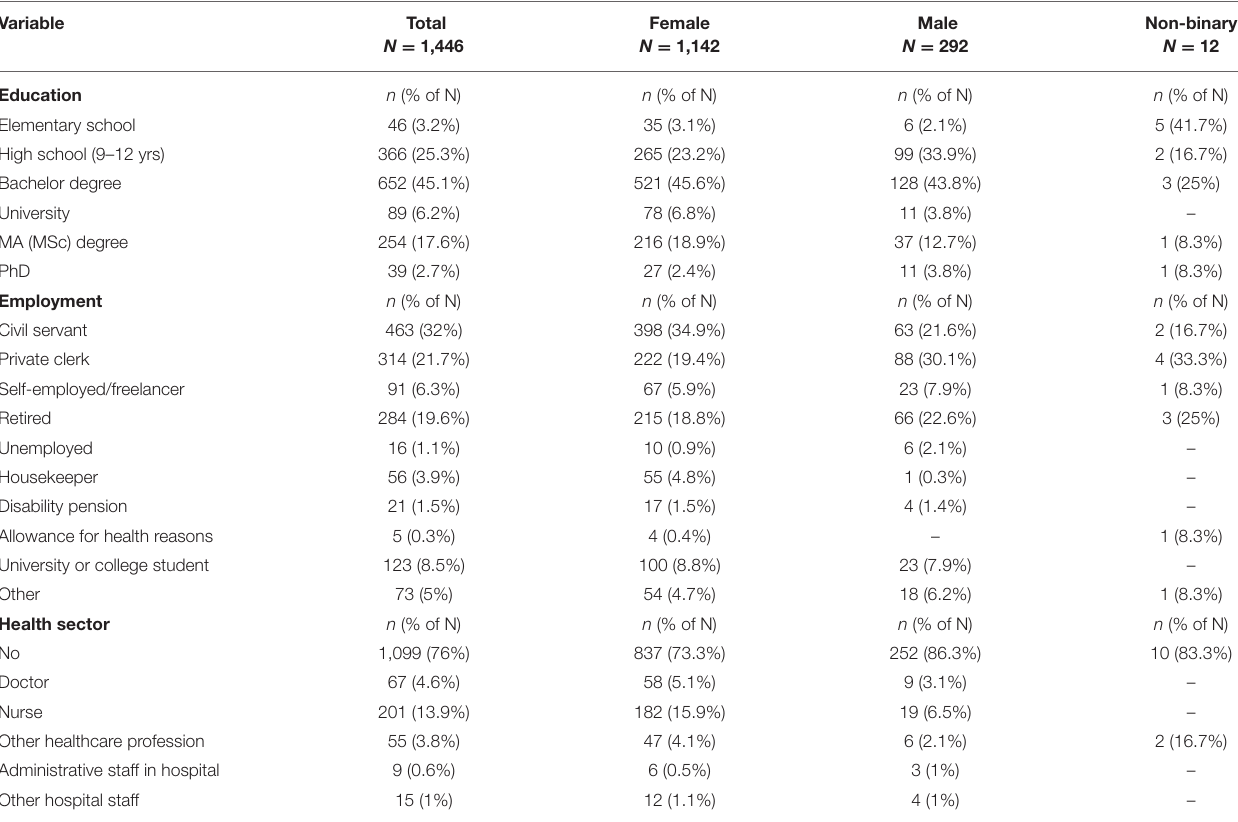
TABLE 2B | The respondents’ education and employment